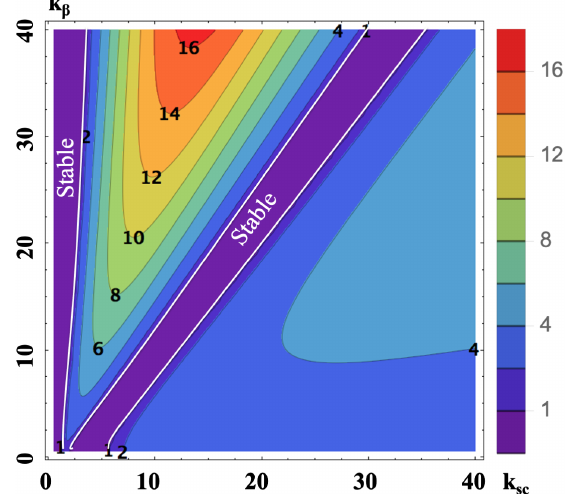
FIG. 4. Contour plots of the absolute value of the cell ’ s growth rate: λ ¼ max ðj Re λ 1 j ; j Re λ 2 jÞ . The purple area highlighted by white lines shows the areas of the stable oscillations j λ 1 Outside of these areas, the oscillations grow